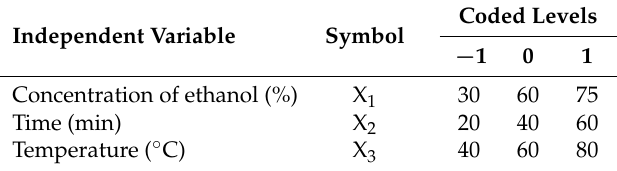
Table 4. Independent variables and their coded and actual values used for